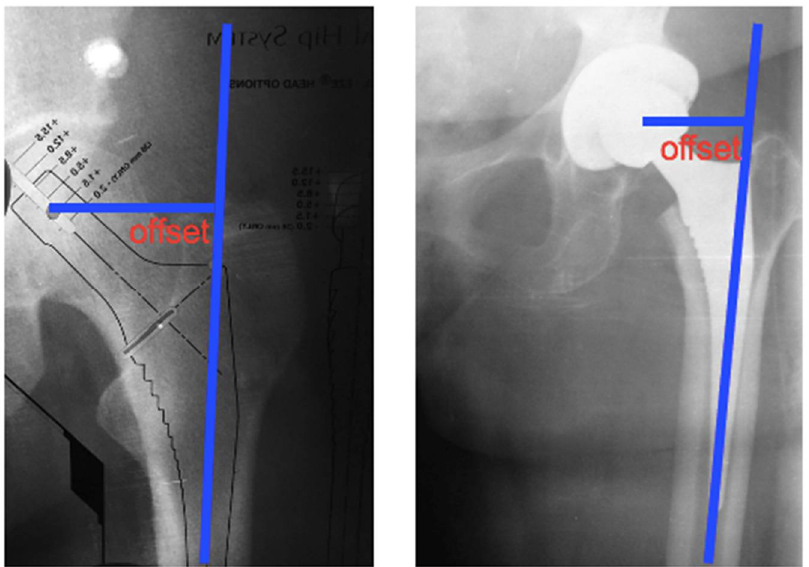
Figure 4. Offset of the femoral component; distance from the center of the femoral head to the axis line of the distal part of the rod.